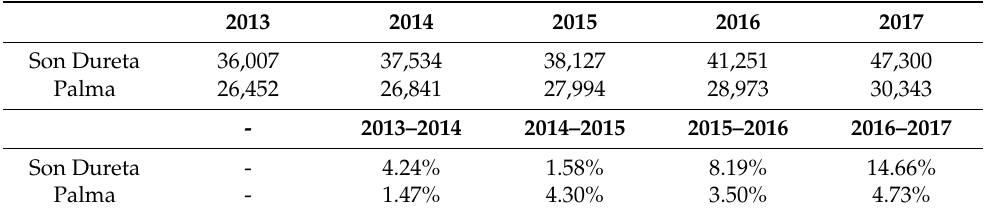
Table 5. Evolution of average gross income indicators 2013–2017. Postal code 07014—Son Dureta. Source: Own elaboration based on statistics of personal income tax filers in the largest municipalities by zip code, Tax